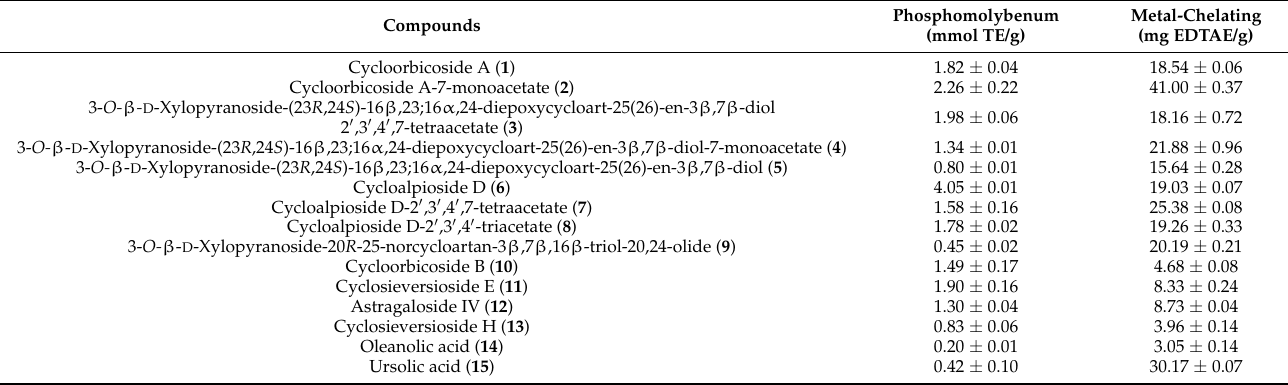
Table 1. Antioxidant activity of fifteen triterpenes, employing the phosphomolybdenum method, and metal-chelating activity on ferrous ion assays.